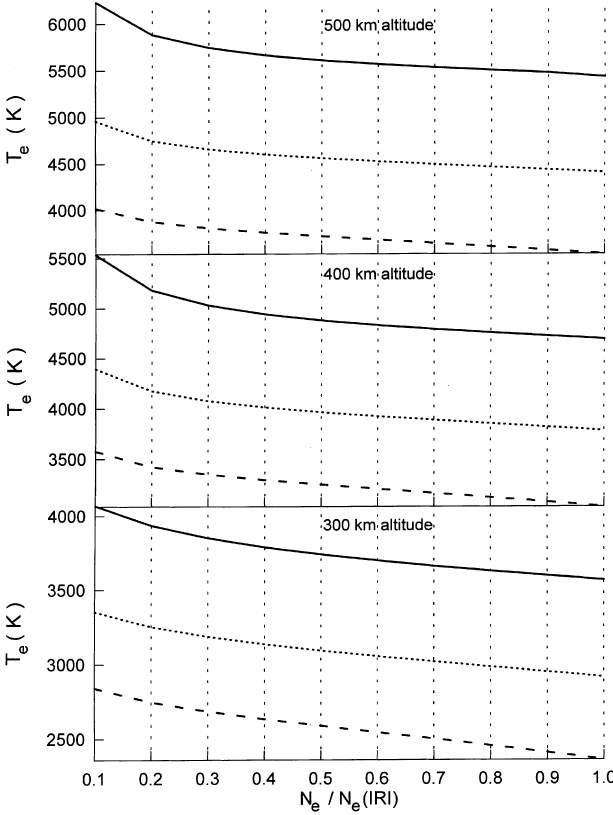
Fig. 1. Variations in the electron temperature at 300km ( bottom panel ), 400km ( middle panel ), and 500km ( top panel ) resulting from reasonable modifications in the electron density from 120km to 1400km and the heat flux of electrons at 1400km given as 1 : 0 (cid:1) 10 11 eVcm (cid:255) 2 s (cid:255) 1 ( solid lines ), 5 : 0 (cid:1) 10 10 eVcm (cid:255) 2 s (cid:255) 1 ( dotted lines ), and 2 : 5 (cid:1) 10 10 eVcm (cid:255) 2 s (cid:255) 1 ( dashed lines ) at 23 : 00LT on 18 December, 1971, in the SAR arc region at the geographic latitude 42 (cid:14) and geographic longitude 279 : 5